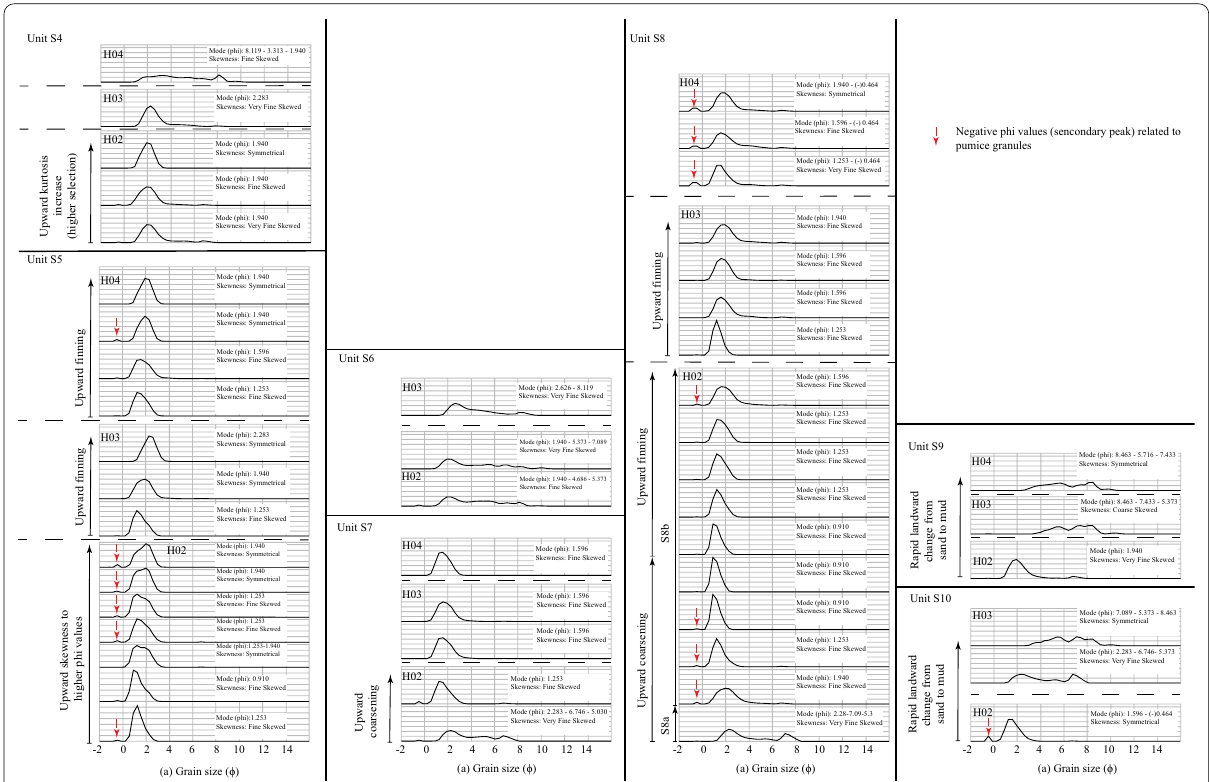
Fig. 7 Grain size analysis result for core sample H02, H03, and H04. Every square depicts the distribution obtained for every sand on every core sample. Every distribution corresponds to ~ 1 cm thick. The figures are not at vertical